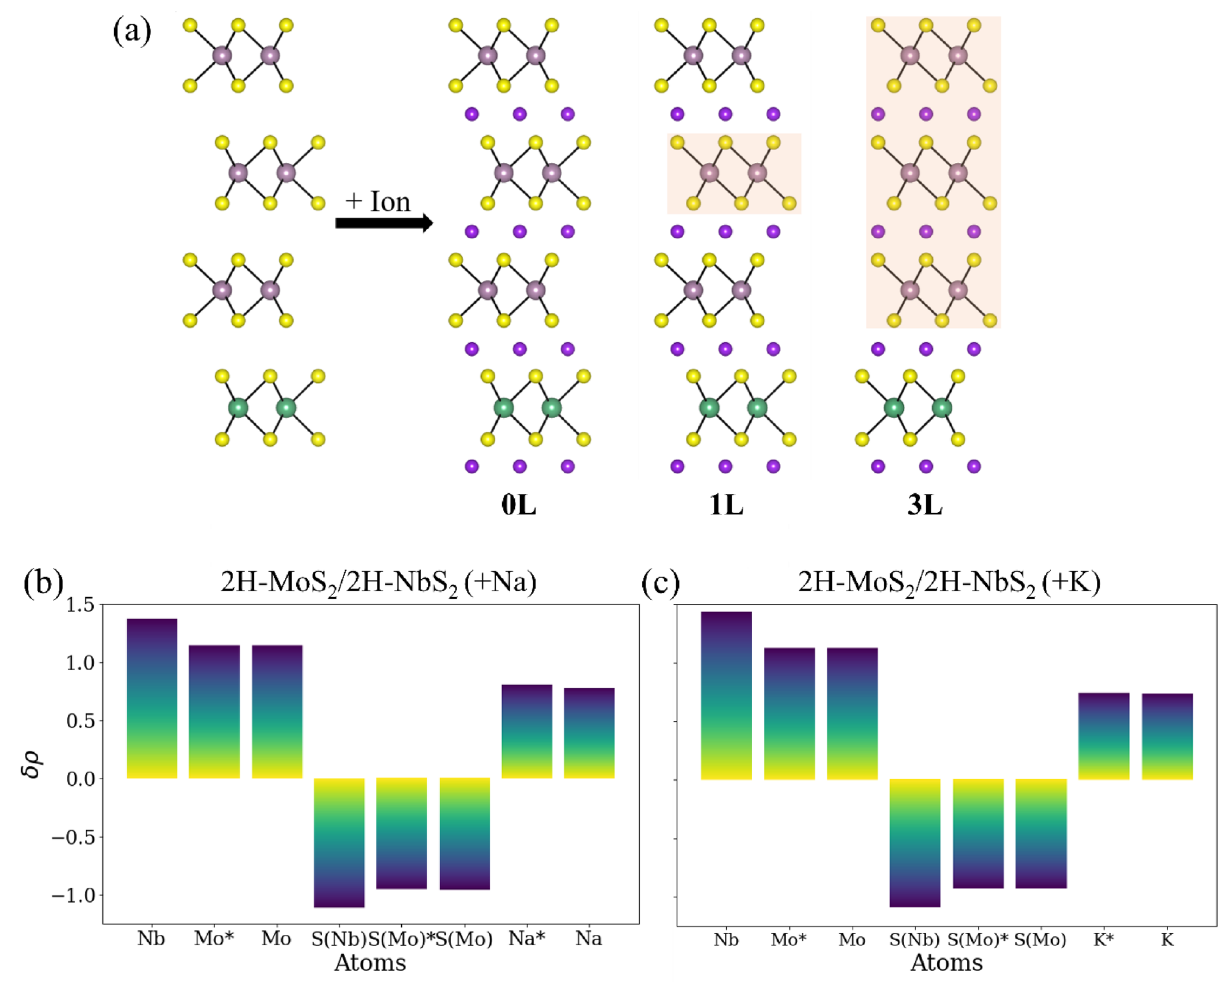
Figure 4. ( a ) (left) Schematic representation of the 3-MoS 2 /1-NbS 2 heterostructures showing a repeating unit of three MoS 2 layers and one NbS 2 layer. Light purple, green, yellow, and darker purple spheres represent Mo, Nb, S, and intercalating ions- Na or K, respectively. 1T-MoS 2 is highlighted in orange. Charges transferred from different atoms in ( b ) Na-ion intercalated and ( c ) K-ion intercalated lowest energy structure 0L: 2H-NbS 2 /2H- MoS 2 computed using Bader analysis. A positive value implies that the atom lost electrons, while a negative value indicates that the atom gained electrons. S(Mo) identifies S atoms bonded to Mo, while S(Nb) refers to S atoms bonded to Nb atoms. Asterisks (*) are marked to identify Mo and S(Mo) atoms neighboring NbS 2 layers and Na- or K-ions intercalating the interface between NbS 2 and MoS 2